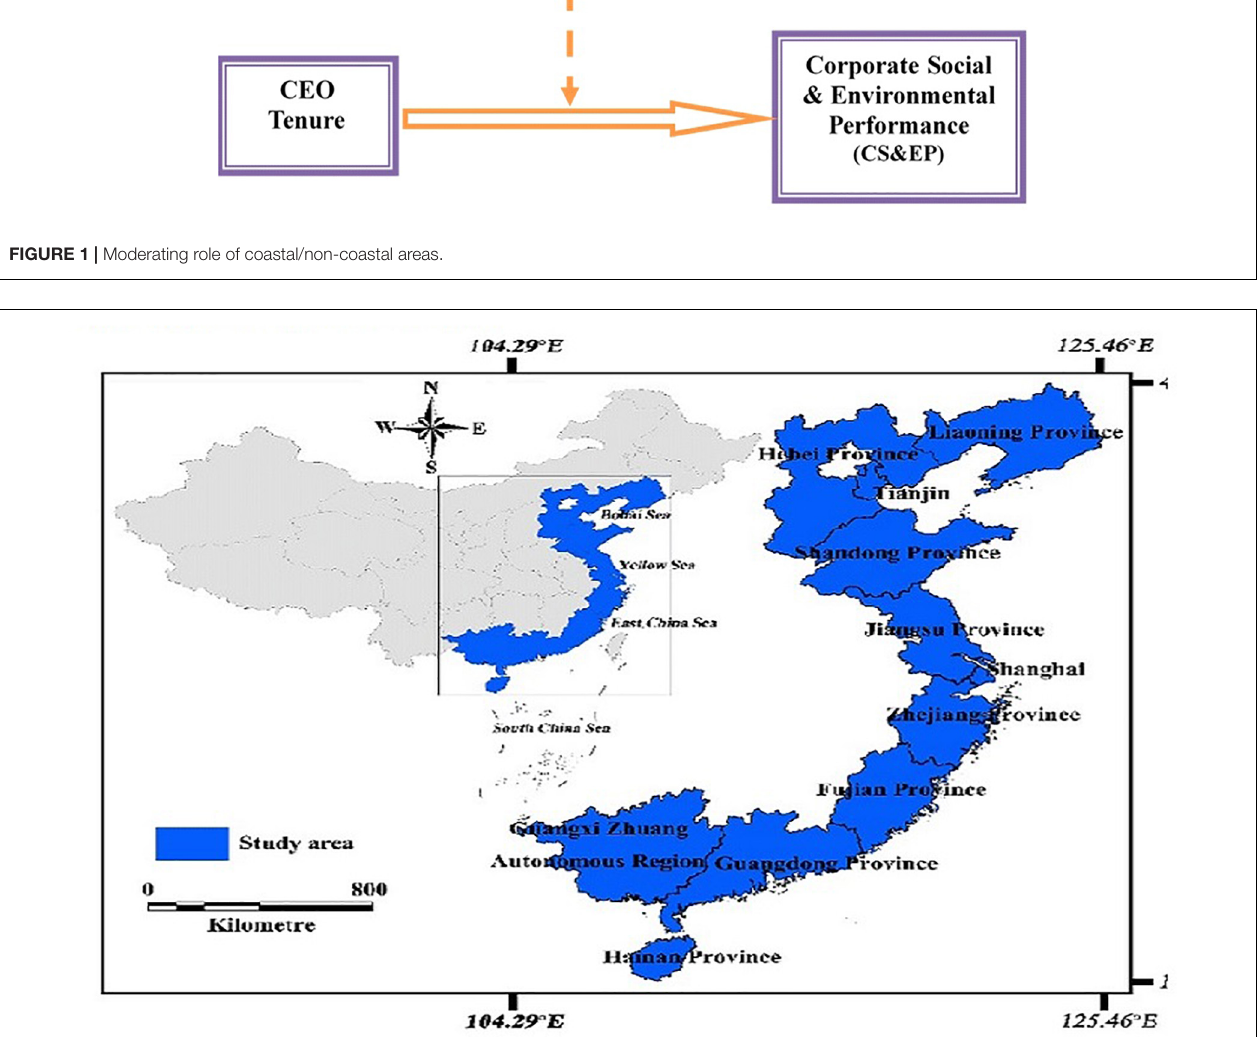
FIGURE 2 | Coastal areas of